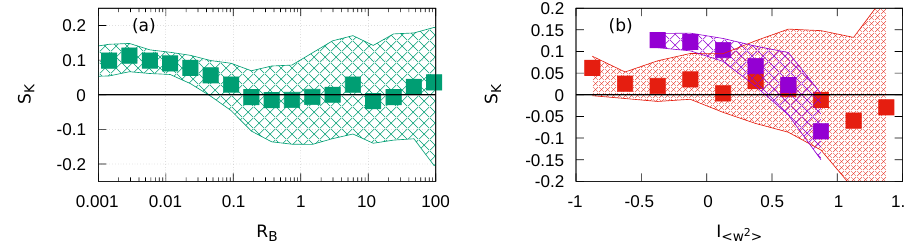
Figure 6. ( a ) Vertical velocity skewness S K = (cid:104) w 3 (cid:105) / (cid:104) w 2 (cid:105) 3/2 (30 min averaged) vs. R B . Symbols and colors are the same as in Figure 1a; ( b ) S K vs. I (cid:104) w 2 (cid:105) for near-neutral cases (blue) and stable cases